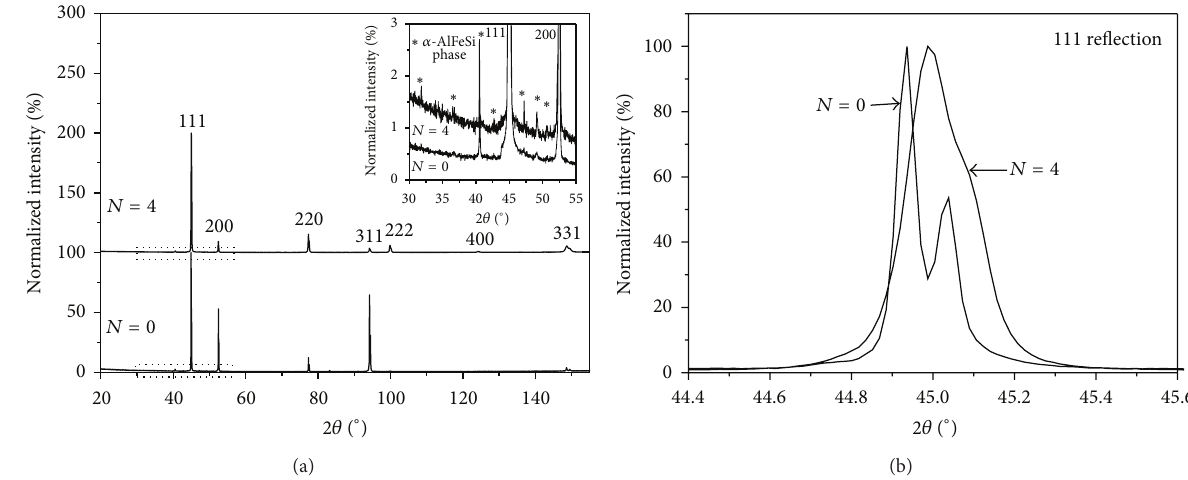
Figure 1: (a) X-ray diffraction pattern and (b) the 111 aluminum reflection of the nondeformed ( 𝑁 = 0 ) and deformed ( 𝑁 = 4 ) aluminium samples. Dashed rectangles are enlarged in the inset showing the 𝛼 -AlFeSi particles reflections.